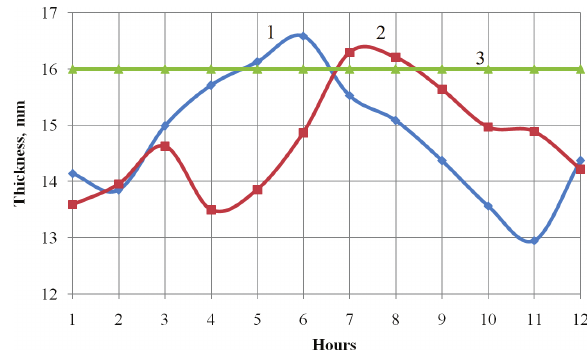
Table 1. Calculations based on EKI-02 (2011).